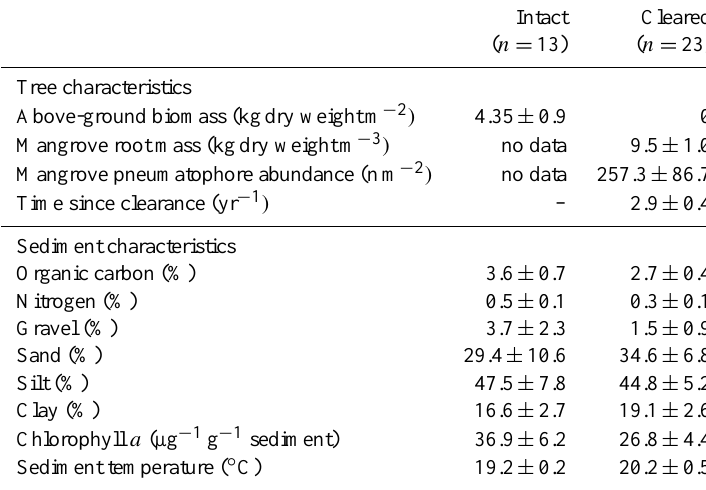
Table 1. Tree and sediment characteristics from intact and cleared mangrove sites. Values are means ± SE.